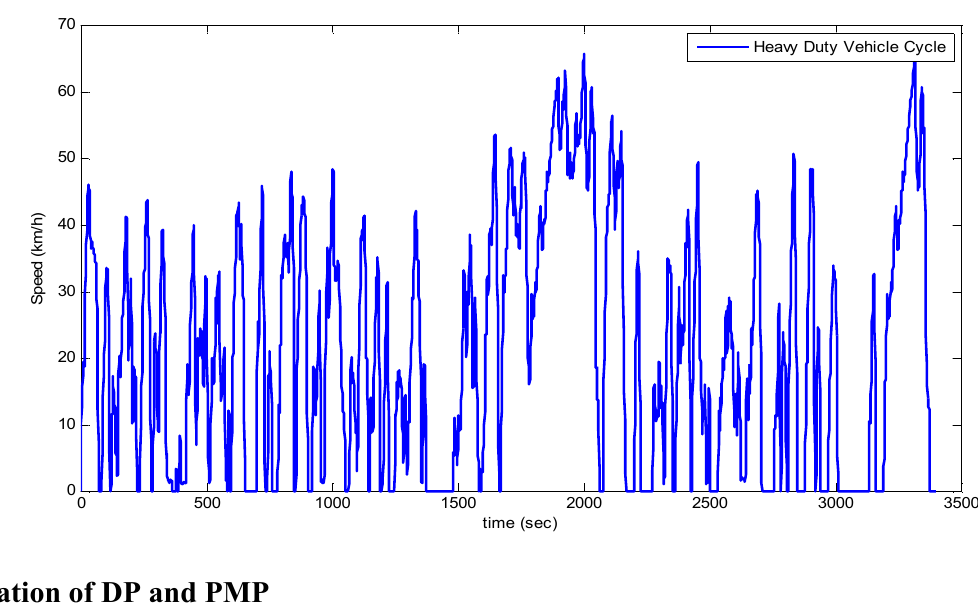
Figure 3. Heavy-duty vehicle natural driving